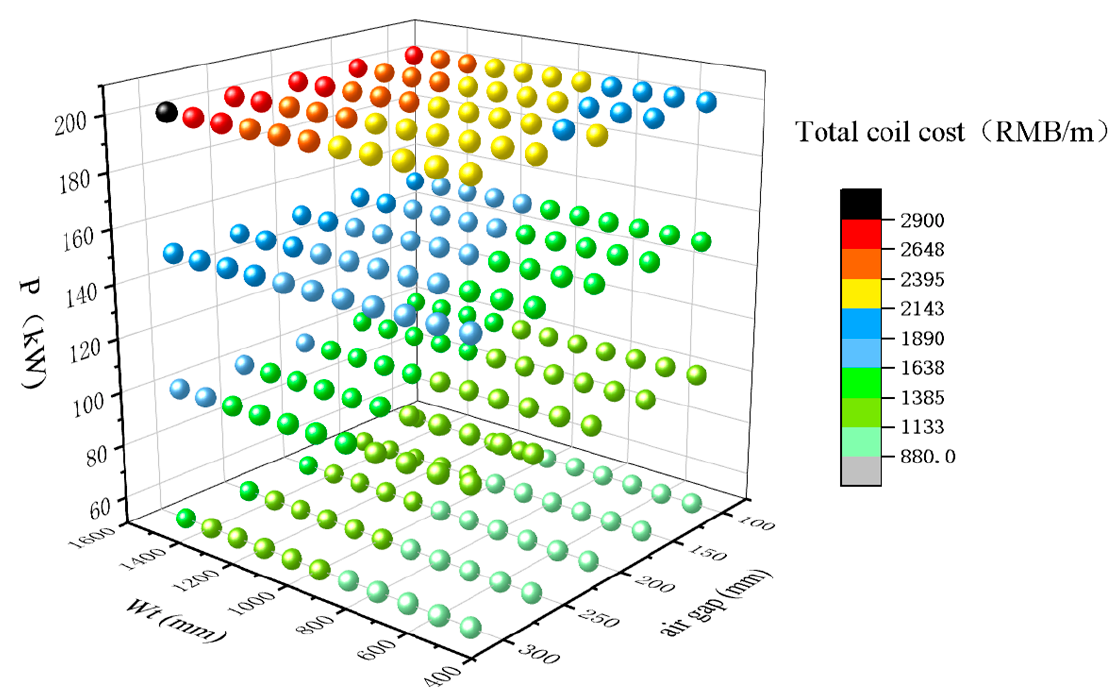
Figure 7. The total cost of the coils under different powers, coil widths, and air gaps.